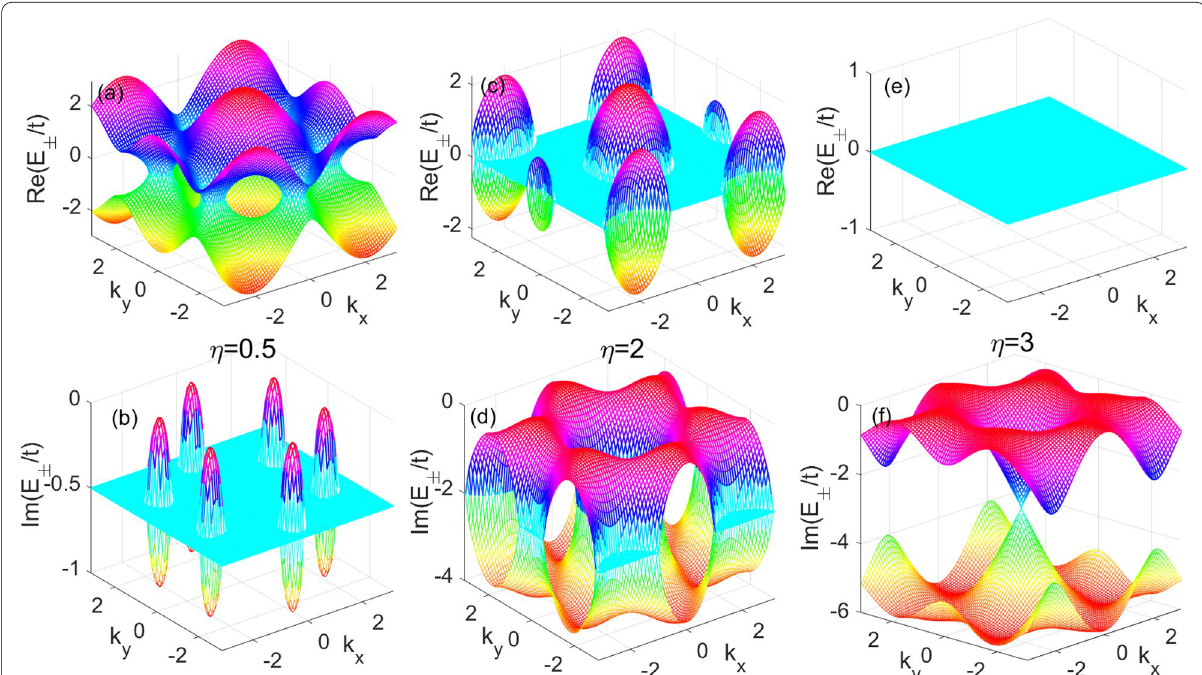
Fig. 2 (Color online): The complex energy band structures in Brillouin zone for different parameter parameters η . a , b The real and imaginary parts of the complex energy structure in η = 0.5 . c , d The real and imaginary parts of the complex energy structure in η = 2 . e , f The real and imaginary parts of the complex energy structure in η = 3 . We set ǫ A =